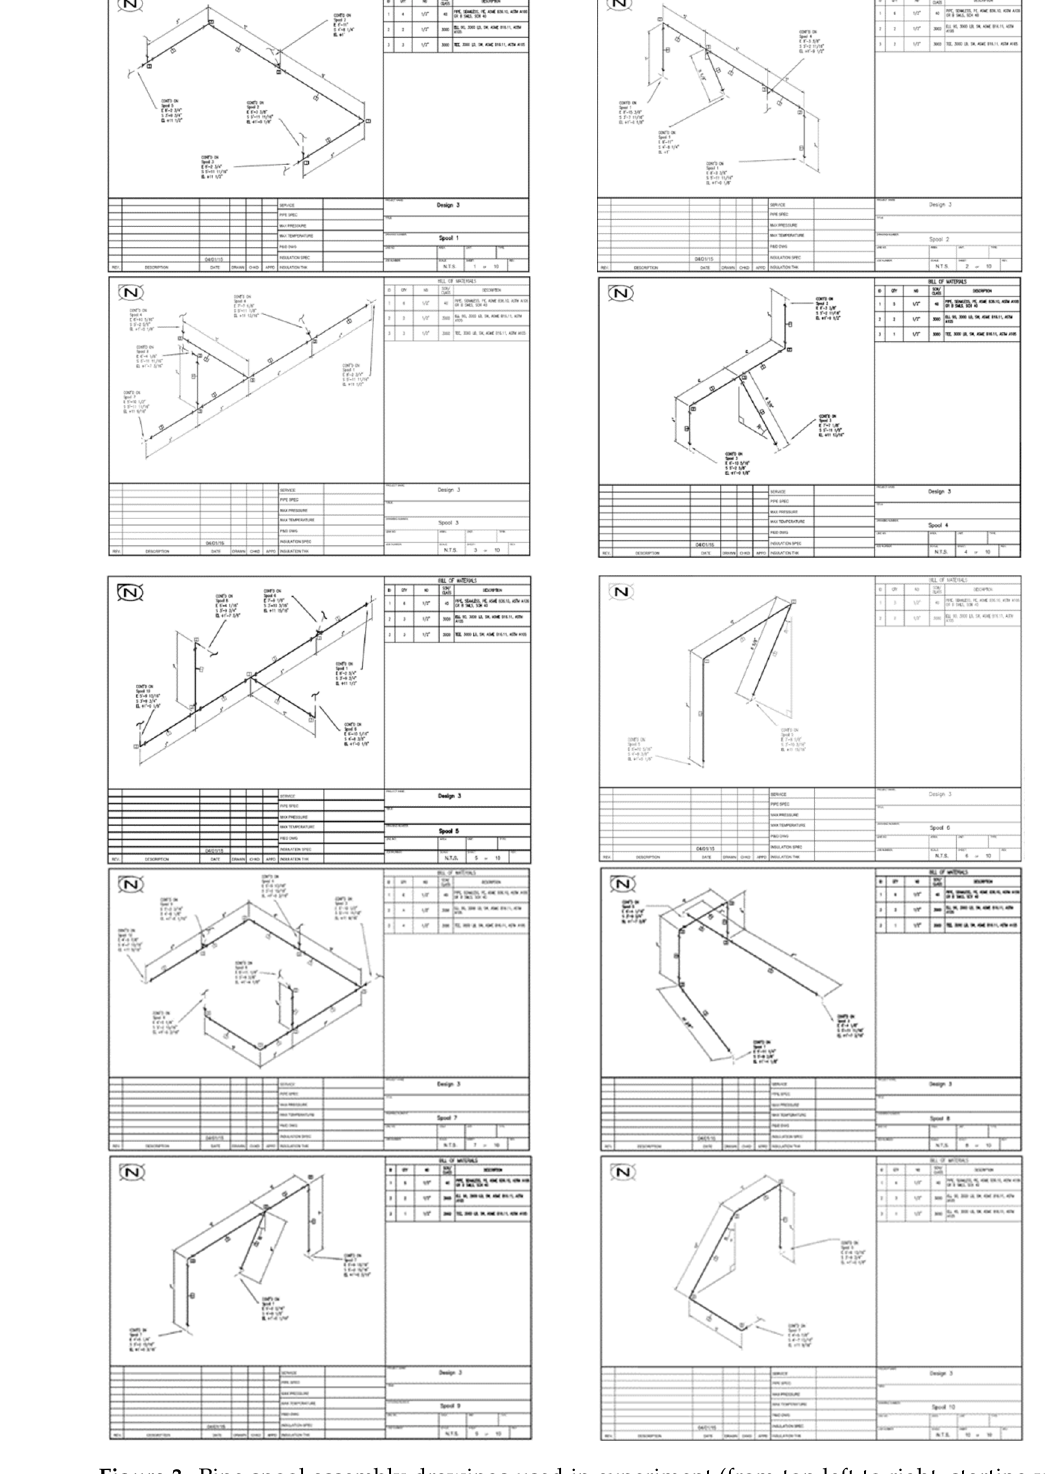
Figure 3. Pipe spool assembly drawings used in experiment (from top left to right, starting with Assembly Drawing 1 and ending with Assembly Drawing 10). Assembly Drawing 1 and ending with Assembly Drawing